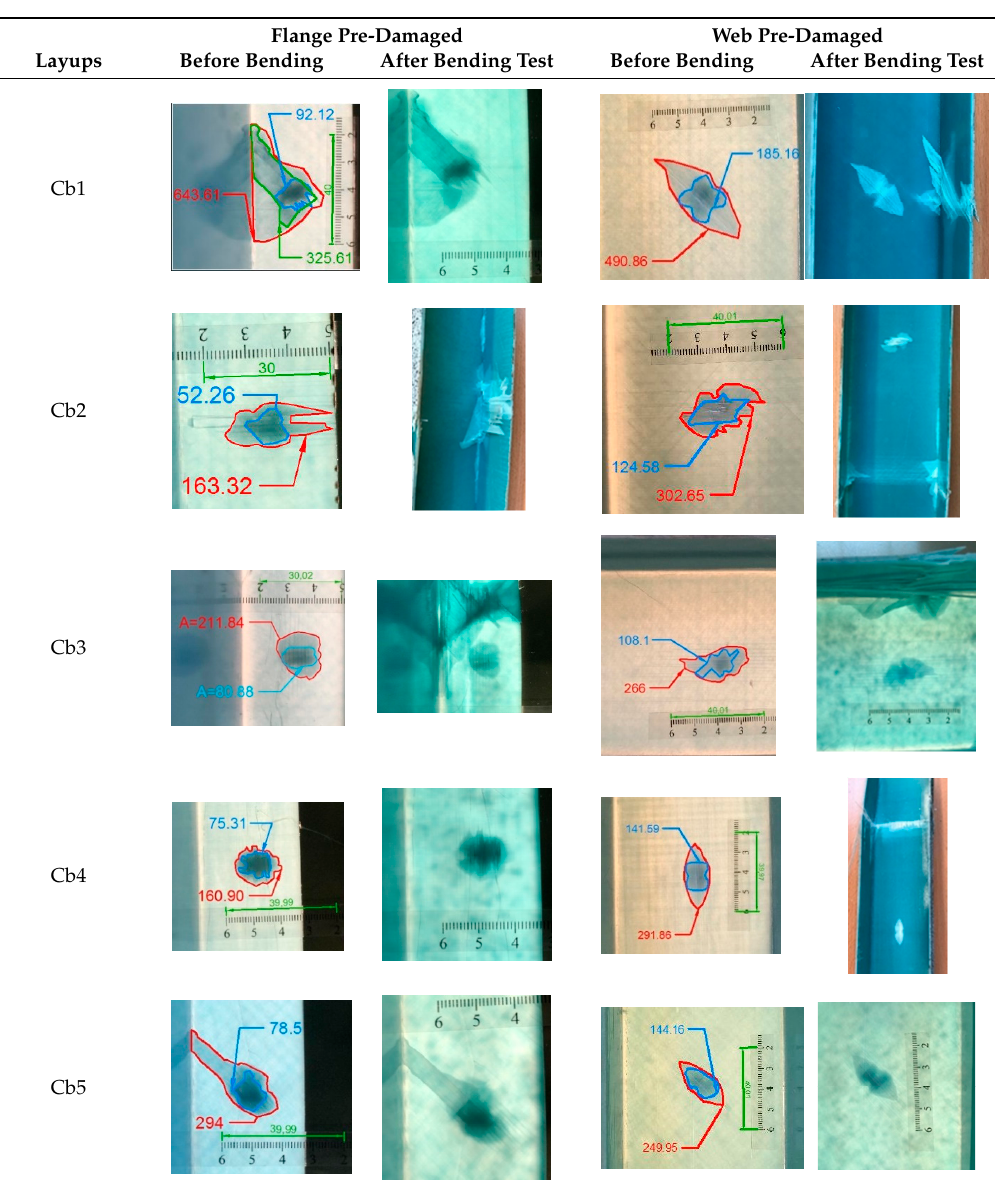
Table 2. Impact pre-damages before and after bending test.